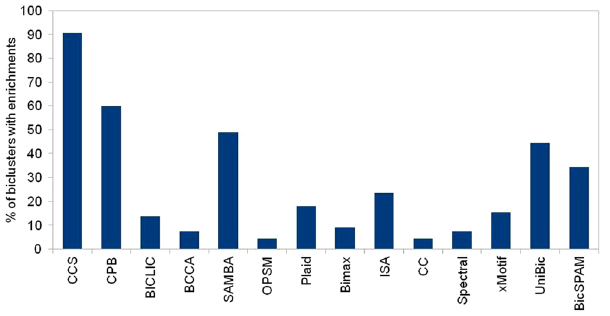
Figure 3. Percentage of bicluster from five gene expression datasets that have at list one enriched term. All the enriched gene ontology terms with Benjamini-Hochberg FDR less than 0.01 were